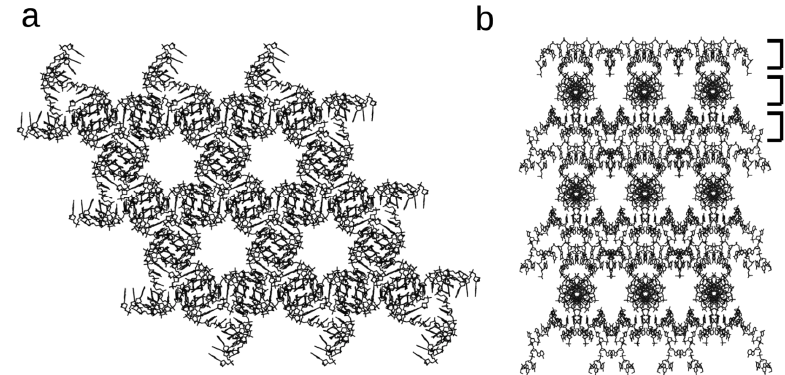
Figure 6. Solvent channels of the 13-mer lattice. Solvent channels run through the 13-mer crystals in multiple directions. ( a ) Solvent channels running down the six-fold axis are ~2 nm in diameter; ( b ) Solvent channels run along each of the three helical layers (shown by brackets) that repeat down the six-fold axis.